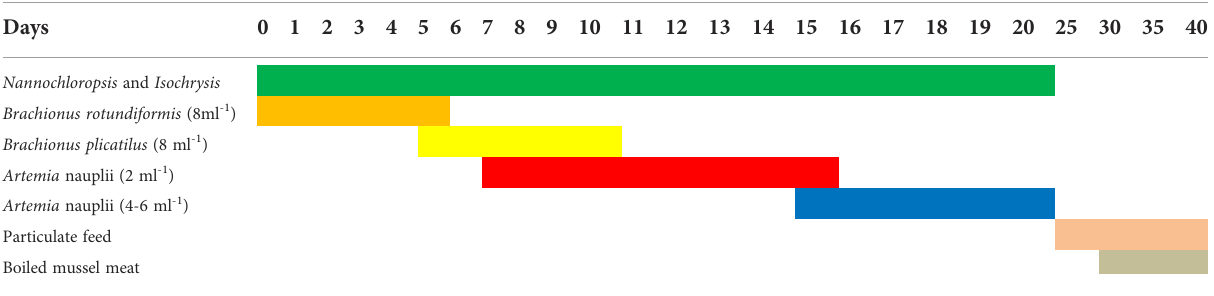
TABLE 5 Feeding schedule of clown fi shes. Feeding schedule of clown fi